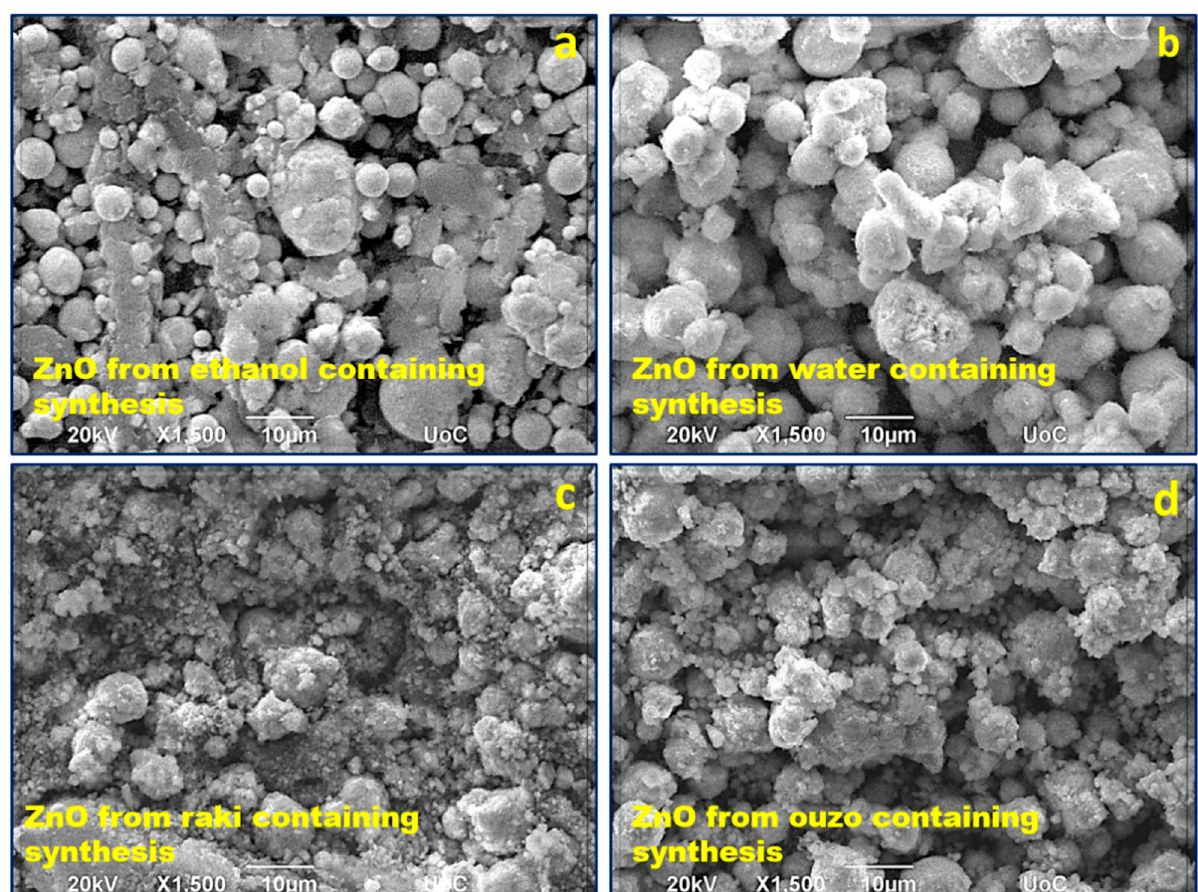
Figure 3. SEM imaging of ZnO synthesized from ( a ) zinc powder and baking NH 3 in ethanol, ( b ) zinc powder and baking NH 3 in water, ( c ) zinc powder and baking NH 3 in ouzo, and ( d ) zinc powder and baking NH 3 in raki.